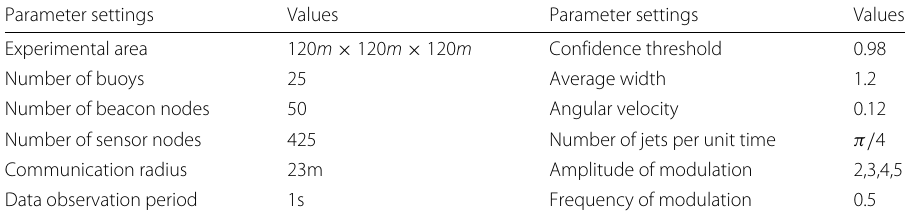
Table 4 Experimental environment and ocean current parameter settings Parameter settings